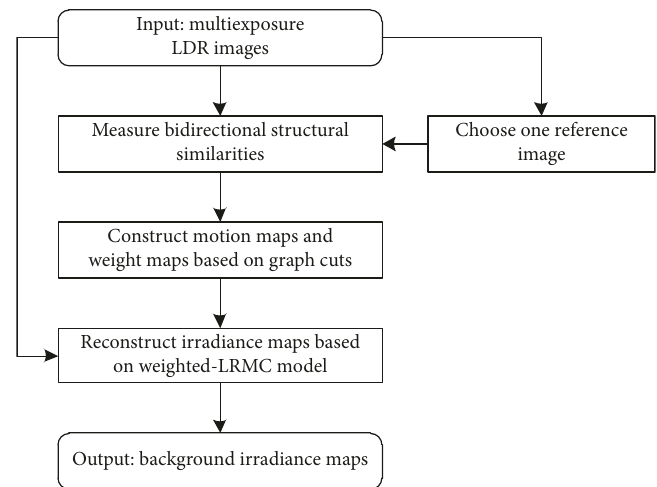
Figure 1: Block diagram of the proposed